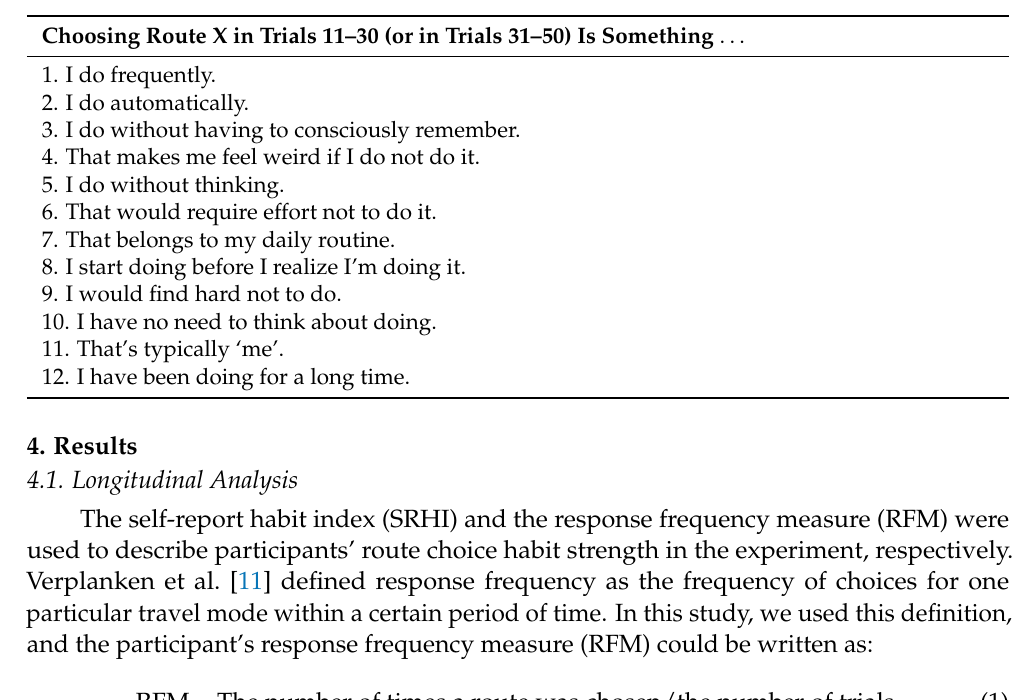
Table 3. The self-report habit index (SRHI).